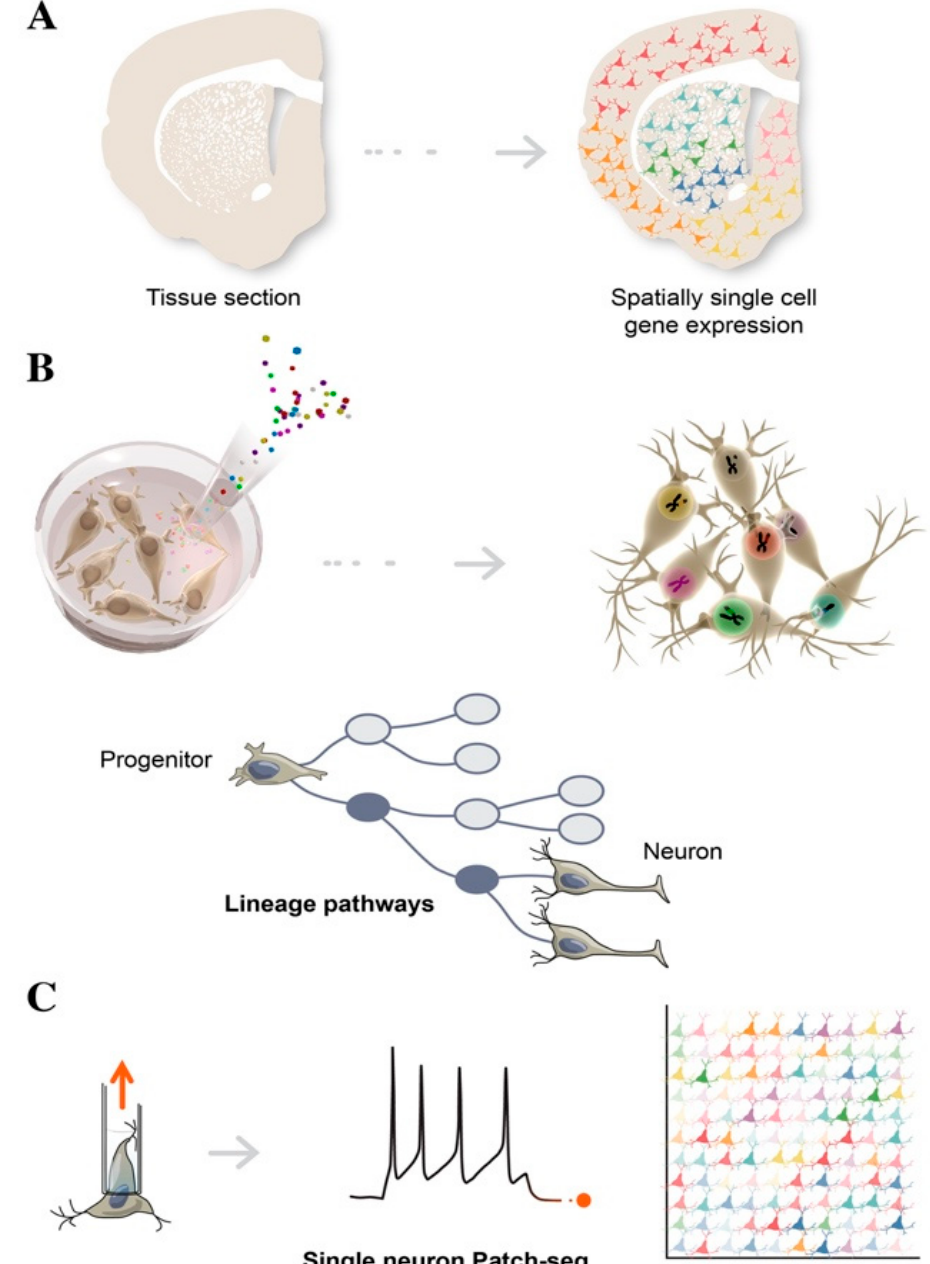
Figure 3. Schematic illustration of single-cell technologies combining transcriptomics with morpho- logical features, to assign cell types to their locations in histological sections ( A ), with developmental lineage tracing to track cellular relationships during development or regeneration ( B ), and with functional analysis to simultaneously profile single-cell transcriptome and electrophysiological properties ( C ).